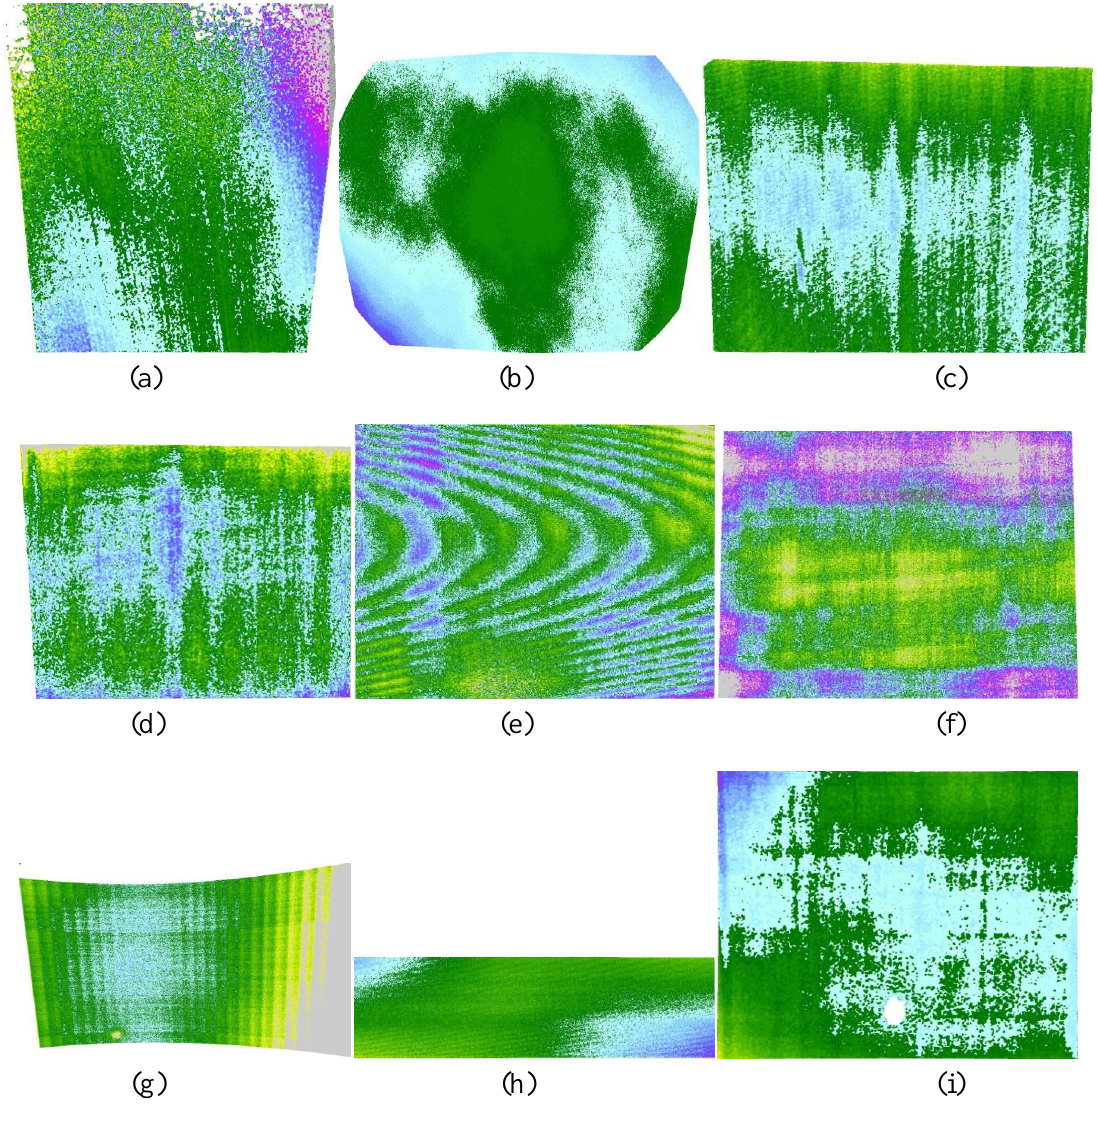
Figure 5. Deviations from the fitting plane of the range devices under test, color coded as in Figure 4a: (a) Nextengine; (b) GOM Atos II; (c) Minolta VI-9i 14 mm; (d) Minolta VI-9i 25 mm; (e) Minolta VI-910 14 mm; (f) Minolta VI-910 25 mm; (g) SG1000; (h) SG100; (i) Minolta